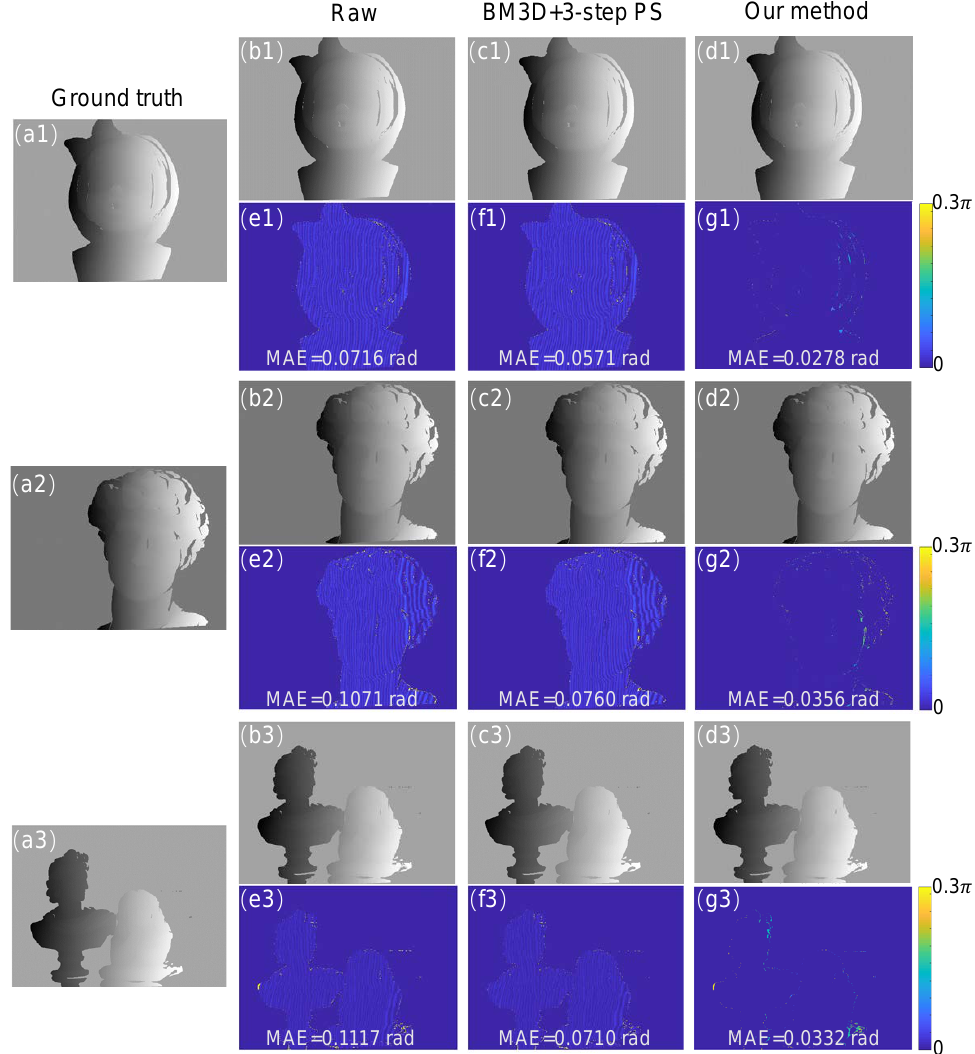
Figure 8. ( a1 – a3 ): The ground-truth label of the unwrapped phase which was calculated by the NIR fringes denoised by BM3D followed by the eight-step phase-shifting algorithm. The unwrapped phase obtained by ( b1 – b3 ) the raw NIR patterns followed by the three-step phase-shifting